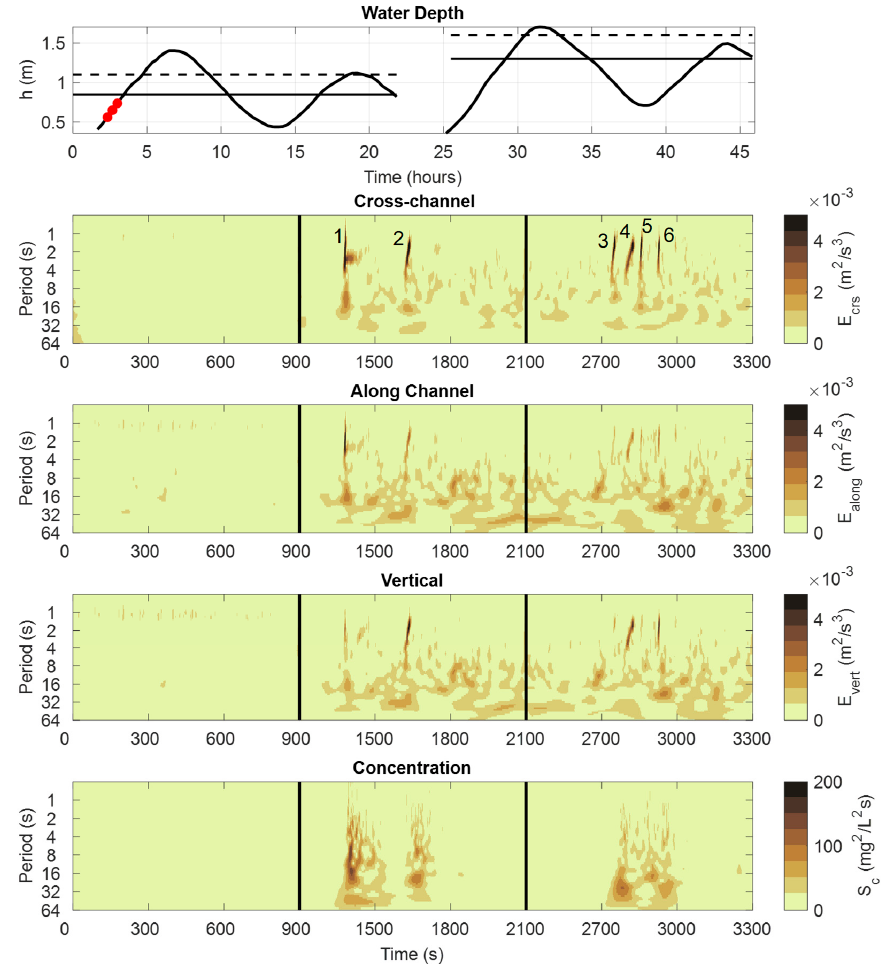
Figure 8. Wavelet decomposition for bursts 8, 9, and 10 depicting the energy density ( E ) for the three components of the velocity and the concentration ( S ). The top panel depicts the three bursts (red circles) as a function of the phase of the tide. The dashed and solid horizontal lines denote the height of the scarp and marsh surface as described in Figure 3. Six vessel wake events (numbered) occurred during this time period. The vertical lines at 900 and 2100 s denote the 5 min gap in the time series record between